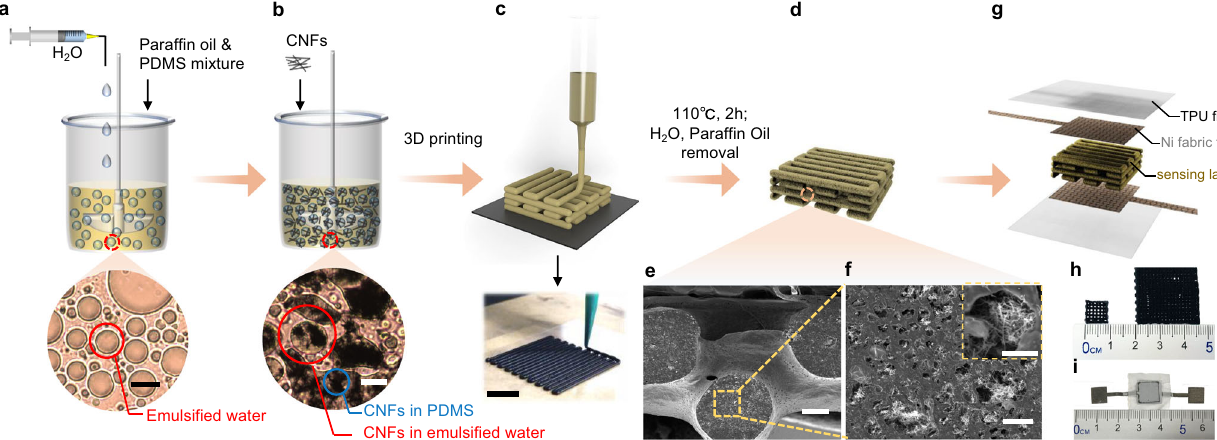
Fig. 1 Overview of the HPPS. Schematic illustration of the fabrication of hierarchical in-situ fi lling porous structure. Schematic diagram and microscope images of a PDMS emulsion, b CNFs/PDMS emulsion (scale bar: 20 µm). c Schematic diagram and optical image of hierarchical in-situ fi lling porous structure by DIW printing (scale bar: 1 cm). d Schematic diagram of hierarchical in-situ fi lling porous structure. e Cross-sectional SEM image of the multilayered lattice structure (scale bar: 200 µm). f Cross-sectional SEM image of inner porous structure in a single lattice rod (scale bar: 200 µm). Inset high magni fi cation SEM image of CNFs networks embedding in a single pore structure (scale bar: 5 µm). g Schematic structure of the HPPS. h Optical image of hierarchical in-situ fi lling porous structure with different sizes. i Optical image of